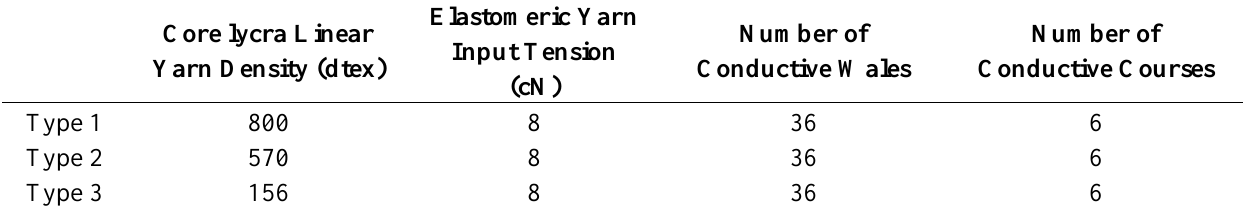
Table 1. Production parameters of sensing structures.